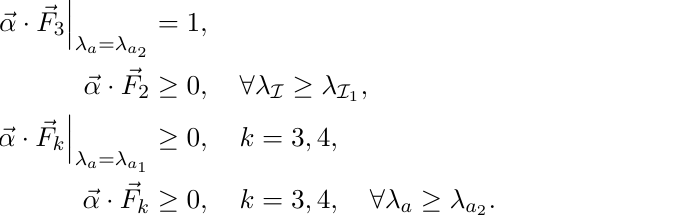
Figure 9 . Upper bounds on j g a 2 ; 4 ; : : : ; 20, assuming that (cid:21) I (cid:21) 0 and (cid:21) a 2 f (cid:21) a